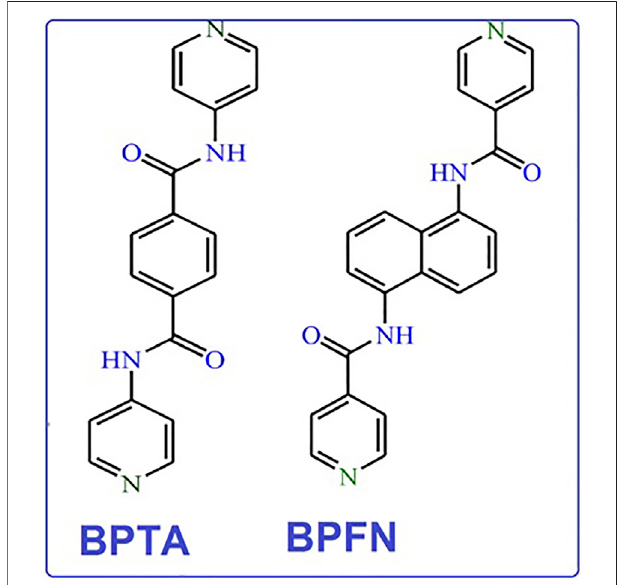
FIGURE 1 | N,N ʹ -bis(4-pyridinyl)-terephthalamide (bpta) and N,N ʹ -bis- (4-pyridylformamide)-1,5-naphthalenediamine (bpfn)